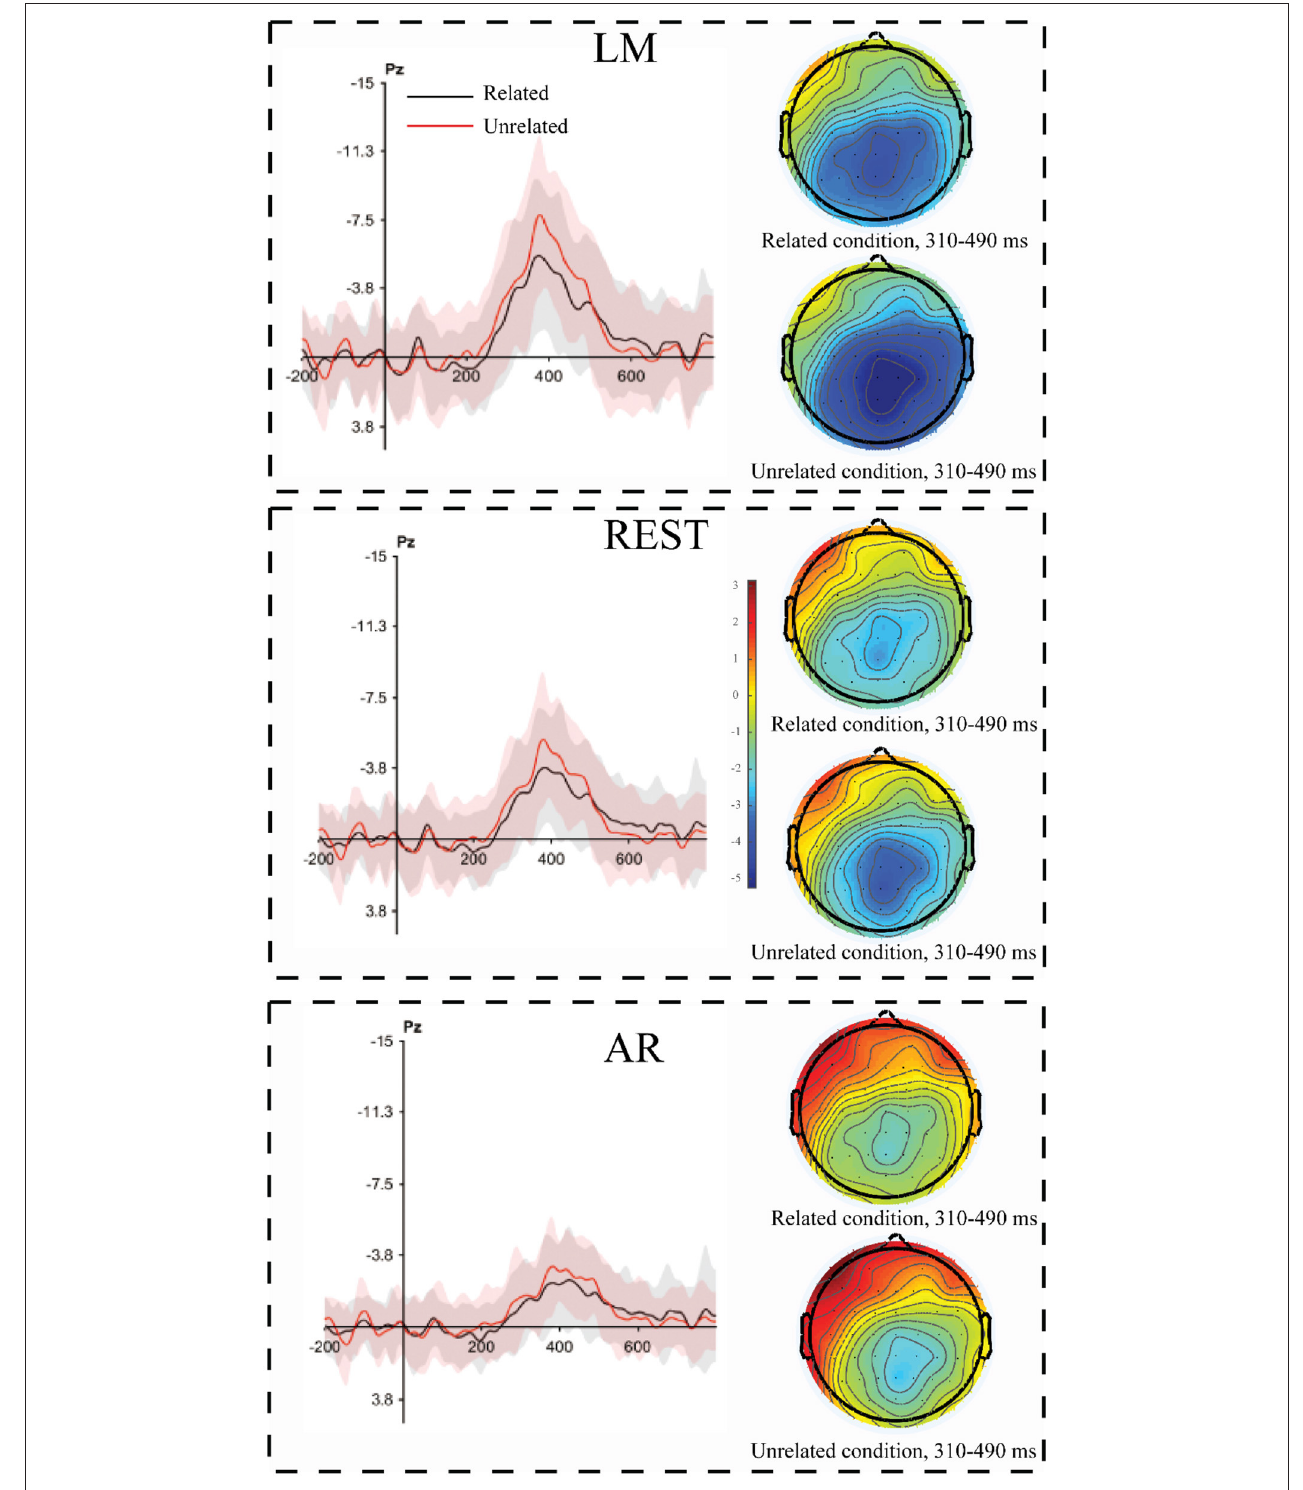
FIGURE 7 | The violation minus antonym difference waveforms as a function of the magnitude of the expectancy violation. The corresponding topographical maps of the N400 effect (310–490ms) for large violations (unrelated condition) and small violations (related condition) revealed a strong central-parietal distribution across all three reference approaches. The shading indicates the standard error across the